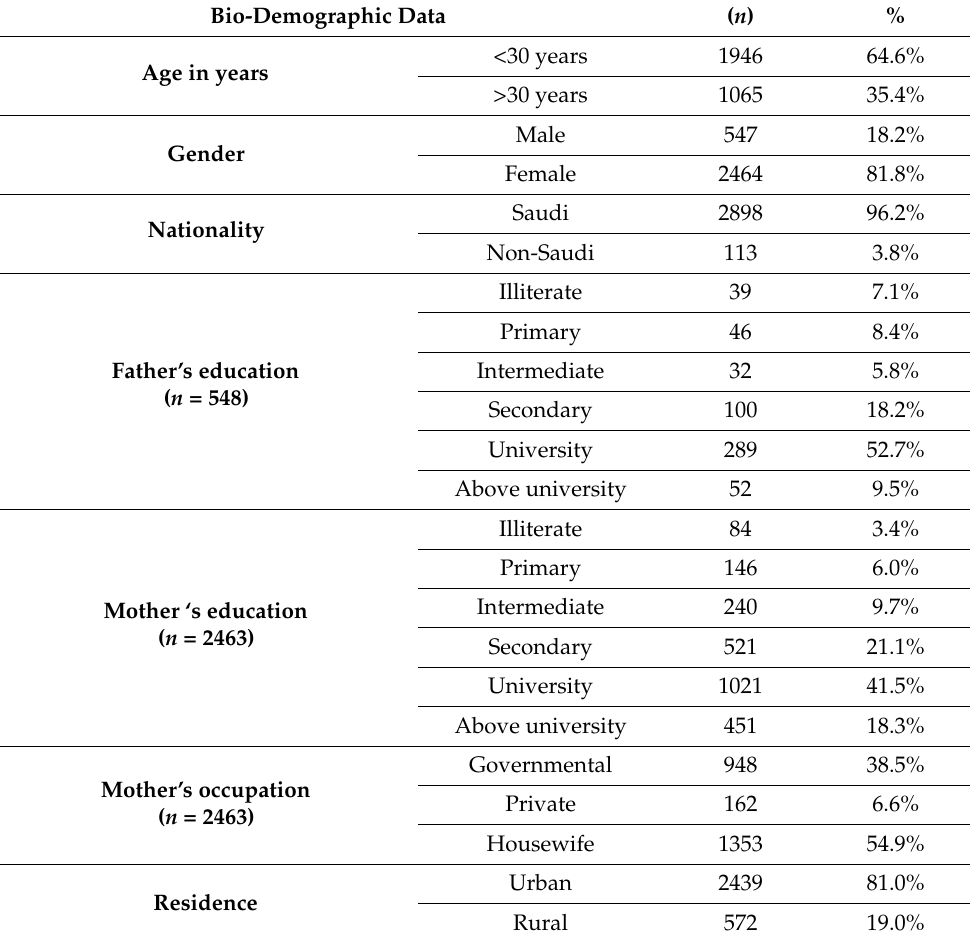
Table 1. Bio-demographic data of study